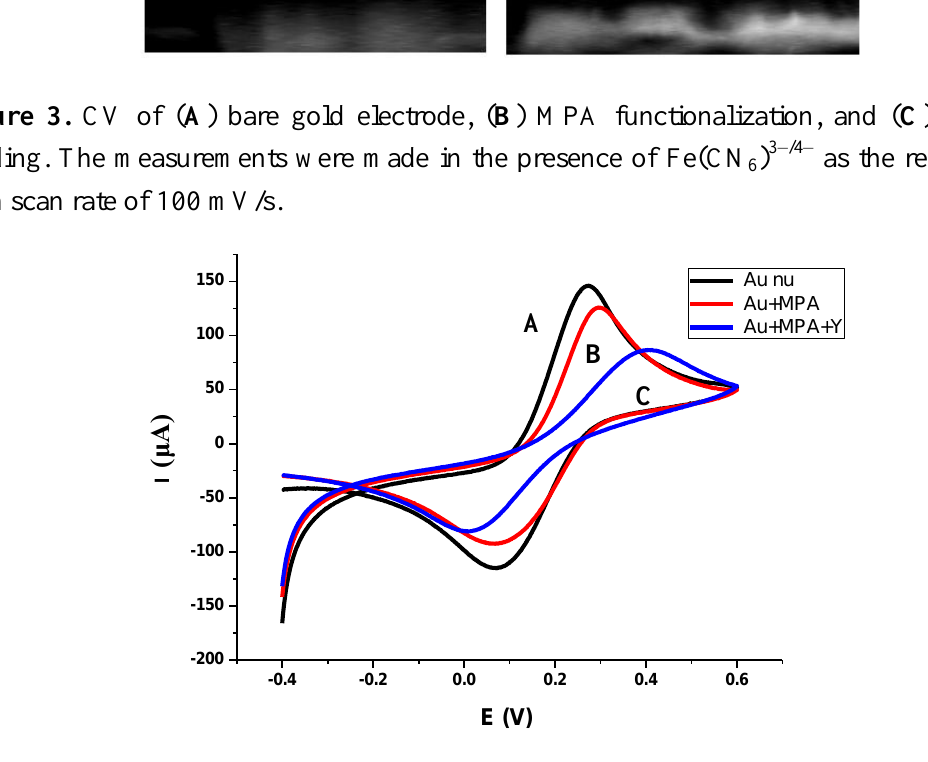
Figure 4. Nyquist plots of impedance spectra for ( A ) bare gold electrode, ( B ) MPA functionalization, and ( C ) antibody binding. The EIS were recorded in the presence of Fe(CN ) 3–/4– at a frequency range between 0.1 Hz and 100 6